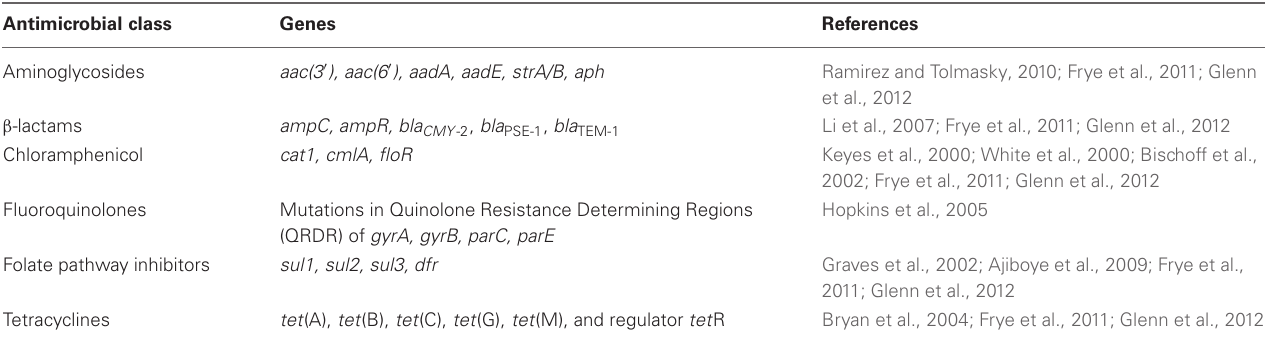
Table 3 | Antimicrobial resistance genes found in Escherichia coli isolated from U.S. food animals. Antimicrobial